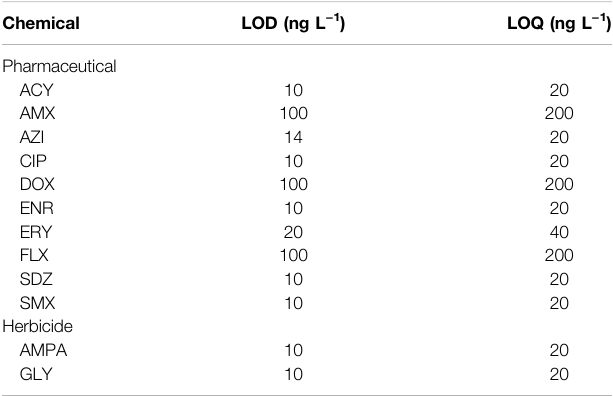
TABLE 1 | Limit of detection (LOD) and limit of quanti fi cation (LOQ) of drugs and herbicides evaluated using a LC-MS/MS (Gomes et al., 2015; Beatriz et